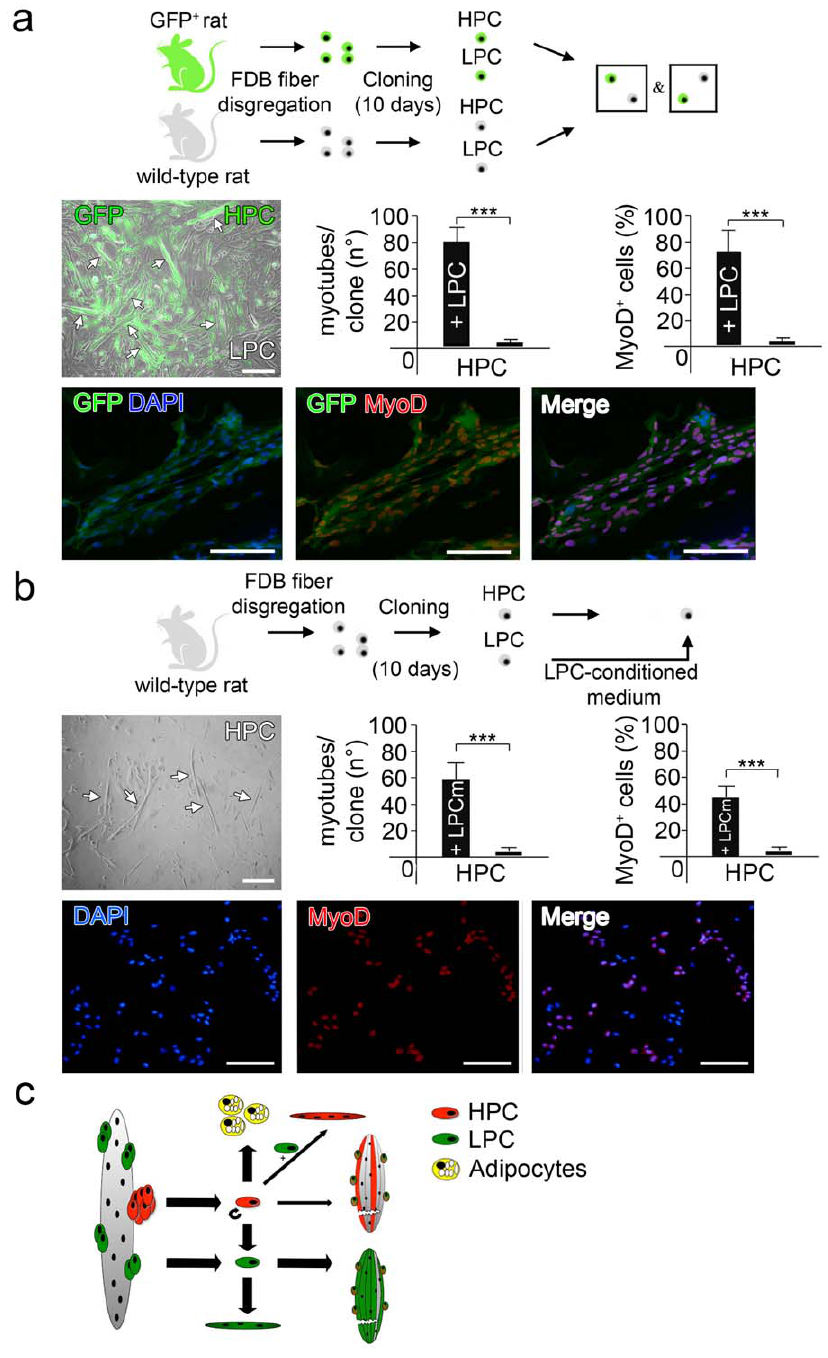
Figure 4. Co-culture of LPC and HPC. (a) Scheme for co-cultures: SCs were derived from FDB muscles of both wild-type and GFP + rats then cloned through limiting dilutions and after 10 days of culture HPC were seeded on LPC (top panel). Increase in myotube formation derived from HPC. Epifluorescence for GFP + myotubes (indicated with white arrows, central panel left, bar=100 m m), and diagrams indicating number of myotubes per clone (central panel, center) and percentage of MyoD + cells (central panel, right) in co-cultures, compared to control HPC (mean values 6 s.d., ***p , 0.001). Immunostaining for MyoD and epifluorescence for GFP, merged with DAPI on co-cultures (bottom panel, bar=100 m m). (b) Scheme for culture in conditioned medium: SCs were derived from FDB muscles of wild-type rats then cloned through limiting dilutions. After 10 days of culture LPC-conditioned medium was transferred on HPC (top panel). Myotube formation (indicated with white arrows, central panel left, bar=100 m m), and diagrams indicating number of myotubes per clone (center) and percentage of MyoD + cells (right) in cultures with LPC-conditioned medium, compared to control HPC (mean values 6 s.d., ***p , 0.001; middle panel). Immunostaining for MyoD on HPC cells, subjected to LPC-conditioned medium, merged with DAPI (bottom panel, bar=100 m m). (c) Cartoon of the current working model: pools of Satellite Cells can be isolated from the muscle fiber and cultured in vitro preserving their original diversities. HPC spontaneously differentiate into adipocytes whilst LPC into myoblasts. Notably, HPC may undergo myogenic pathway if cultured together with LPC. LPC and HPC in vitro diversities mirror differences in the capacity of regenerating damaged muscles tissues.